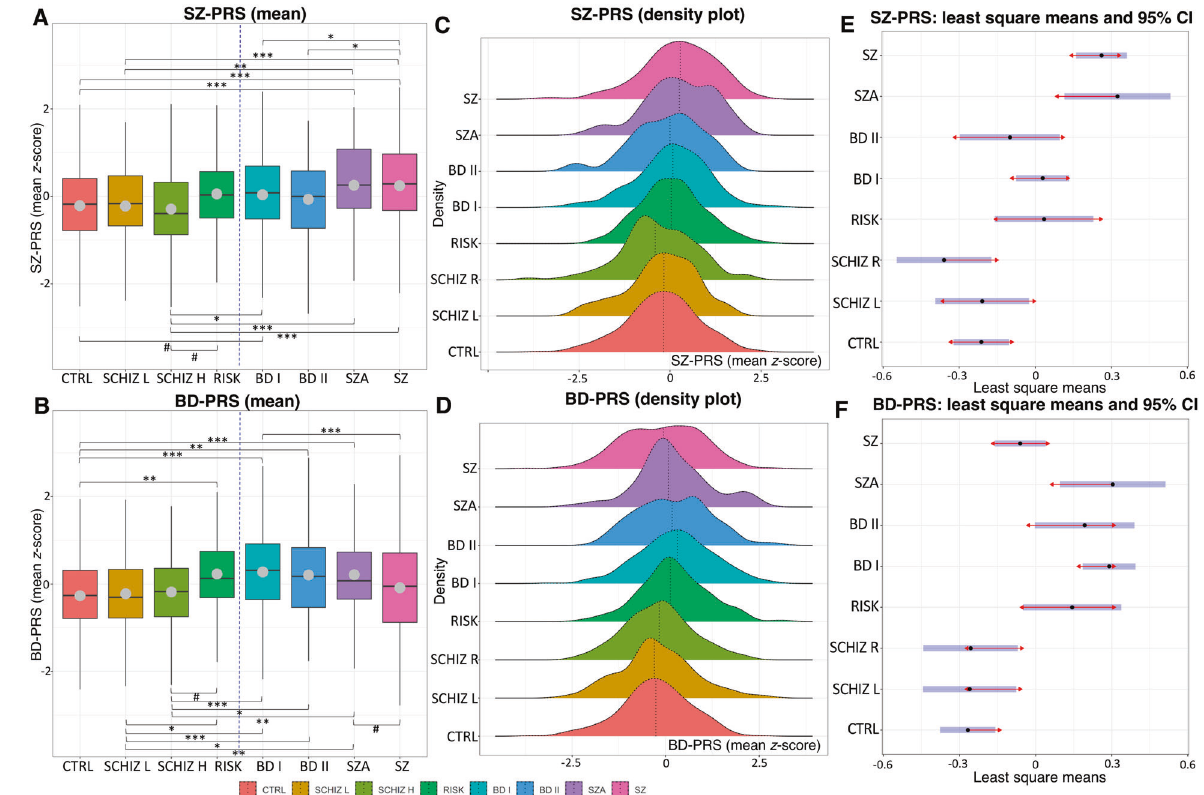
Fig. 1 Mean polygenic risk score (PRS) for schizophrenia (SZ-PRS) and bipolar disorder (BD-PRS) in the eight investigated groups. A , B Each boxplot shows the median (vertical lines) and mean (gray dots) PRS values; whiskers represent the minimum and maximum values; the vertical blue dashed lines separate the groups with subclinical versus clinical symptomatology; brackets with symbols indicate signi fi cantly different pairwise Bonferroni-corrected comparisons at p < 0.05 (*), p < 0.01 (**), and p < 0.001 (***) thresholds as well as comparisons trending toward signi fi cance (#, adjusted p value range, 0.050 – 0.064). The results are adjusted for age, sex, and the fi rst fi ve ancestry principal components. Higher scores indicate a higher polygenic burden. C , D The vertical dotted lines within the colored distributions represent the mean PRS for each group. E , F The blue bars represent con fi dence intervals for each group ’ s least squares mean. If the red arrows for two groups overlap, the difference is not signi fi cant after a Bonferroni correction. Group abbreviations: BD I bipolar I disorder, BD II bipolar II disorder, CTRL control, RISK at-risk state for psychosis, SCHIZ H higher schizotypy, SCHIZ L lower schizotypy, SZA schizoaffective disorder, SZ